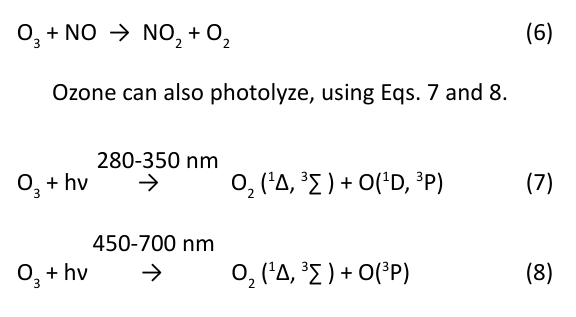
Table 1: Measurements of [SO 2 ], [NO 2 ], [Cl - ] and T annual average in the period 2015-2019 Parameter